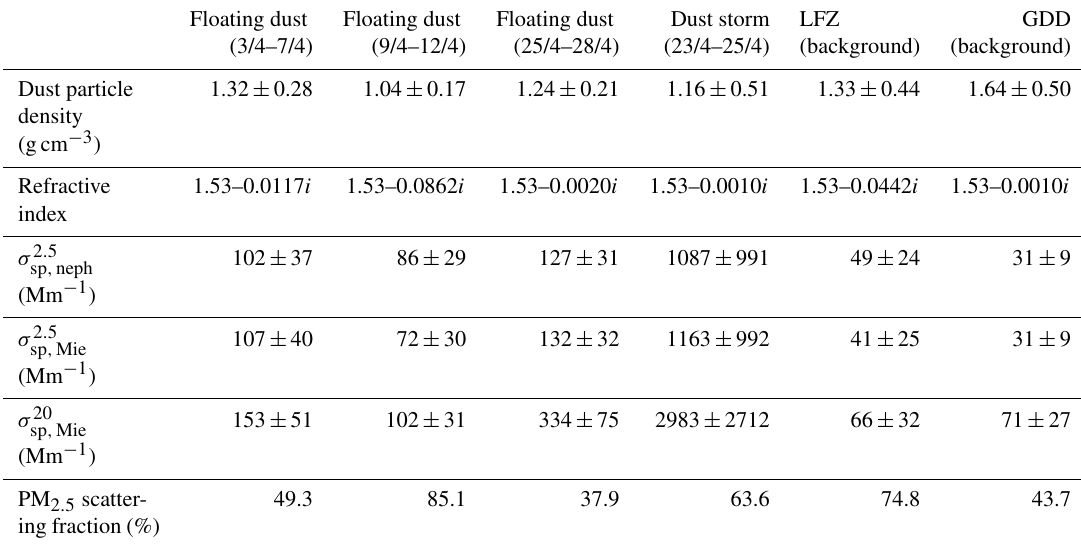
Table 3. Statistical summary of optical and microphysical properties of aerosols in different atmospheric conditions during the dust field